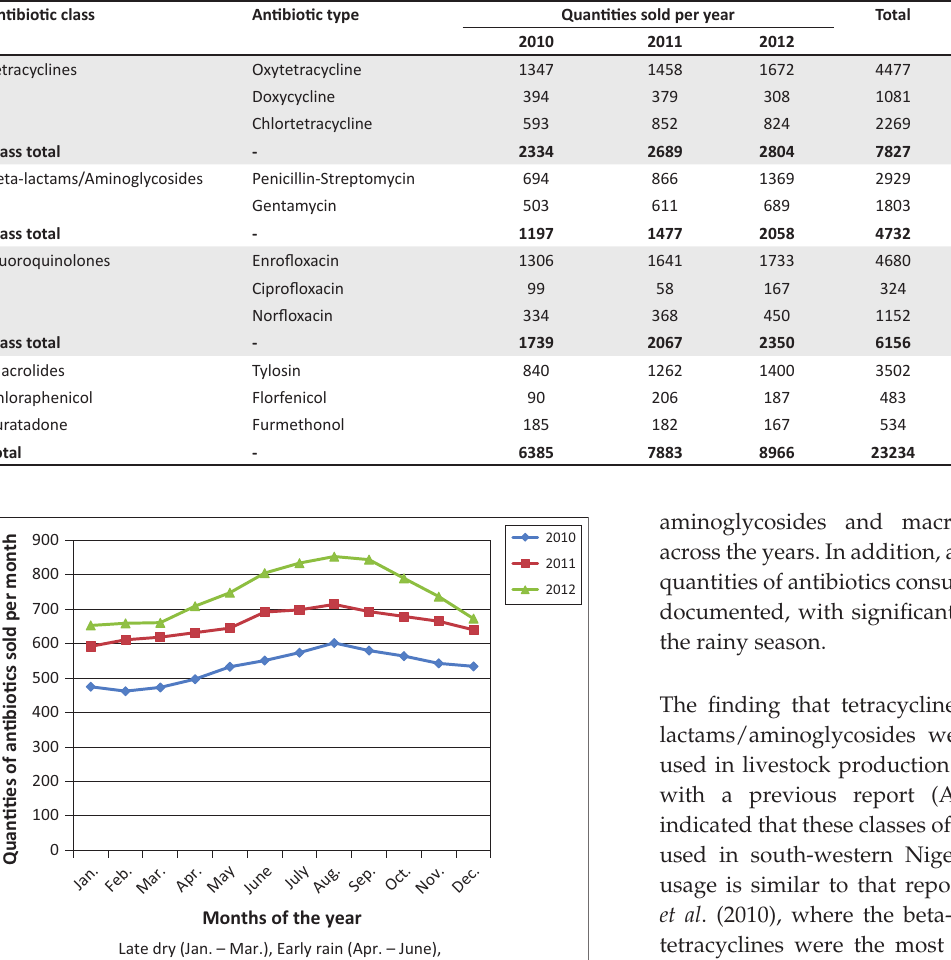
TABLE 2: Patterns of antibiotic usage in livestock production in south-western Nigeria